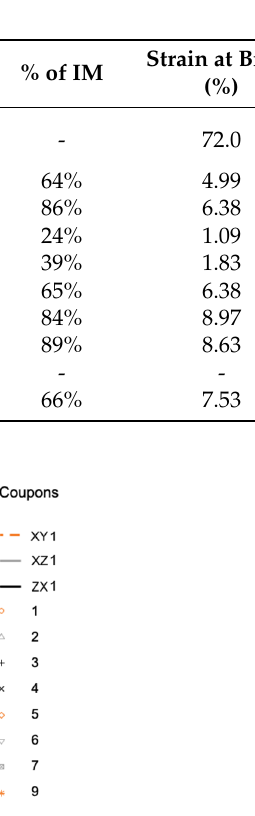
Table 8. Mechanical properties for annealed specimens.